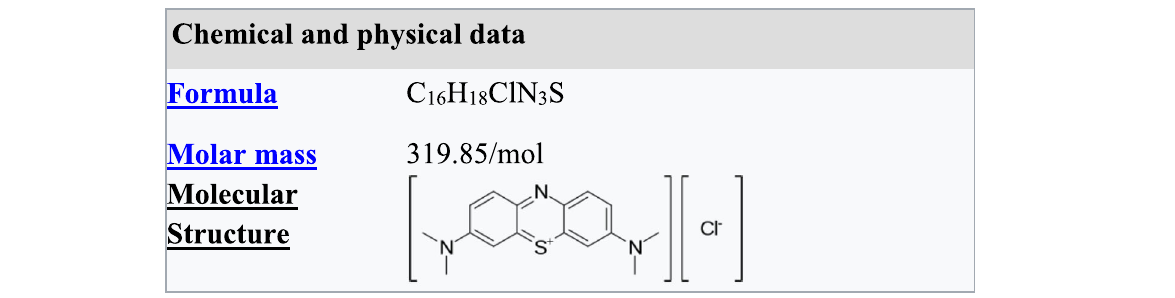
Table 2 Chemical composition of methylene blue